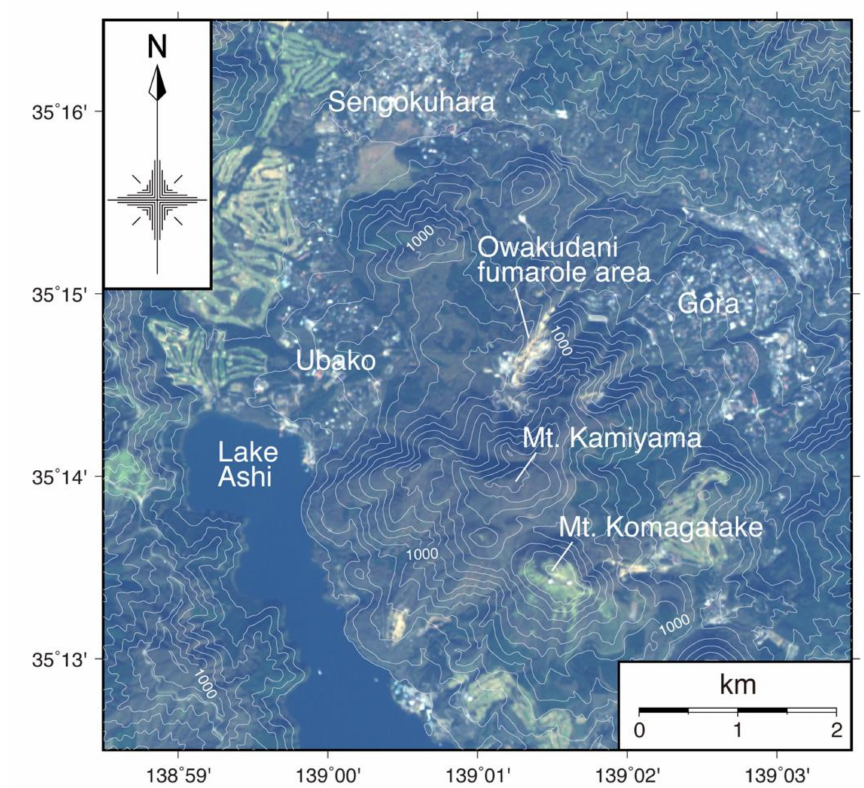
Figure 3. Location map of the focused area of this study. The base map is a true-color image captured by ALOS / AVNIR-2 on 10 November 2006. Contour lines in which intervals are 50 m were extracted from 10 m mesh height data released by the